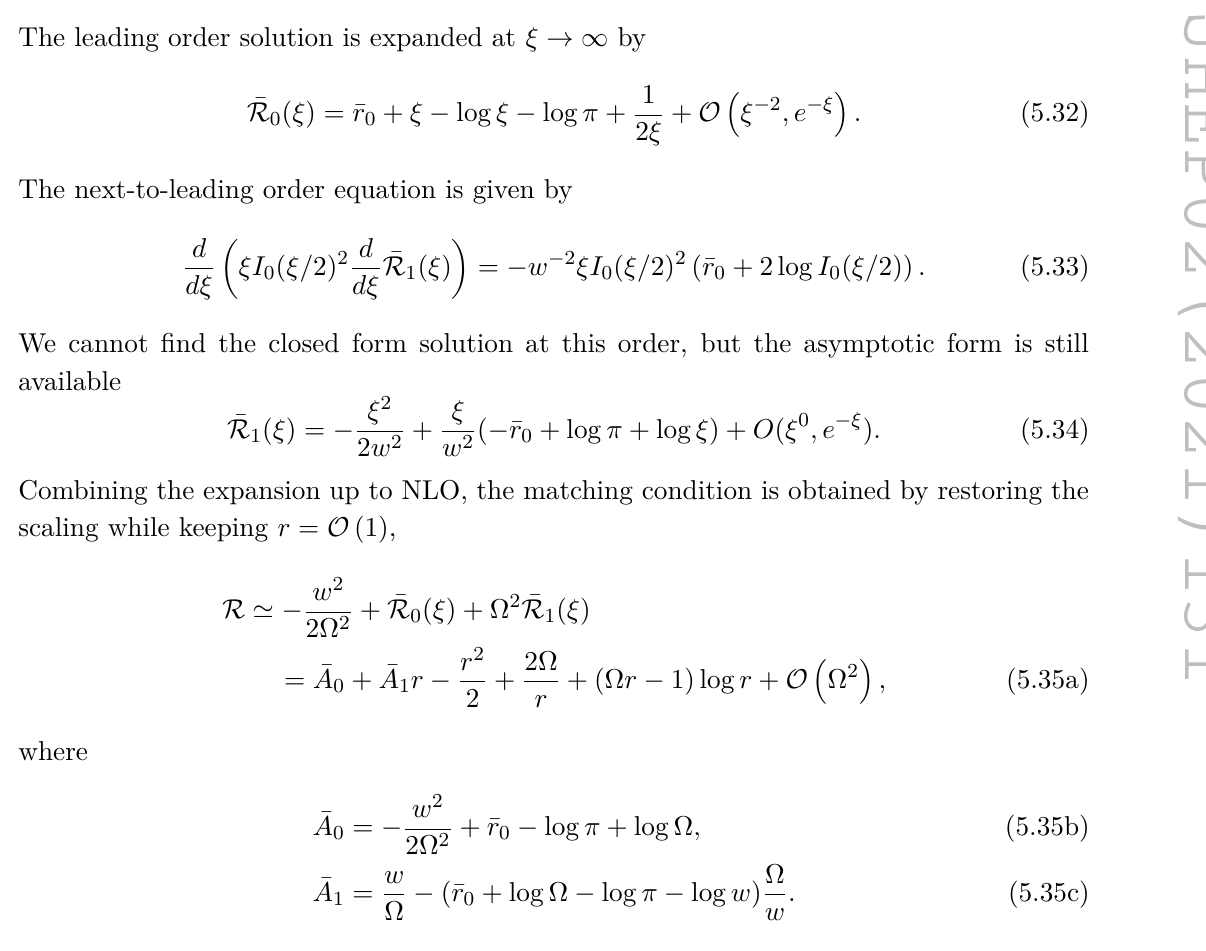
Figure 10 . Long neck structure and its scalings for even (left) and odd ripples